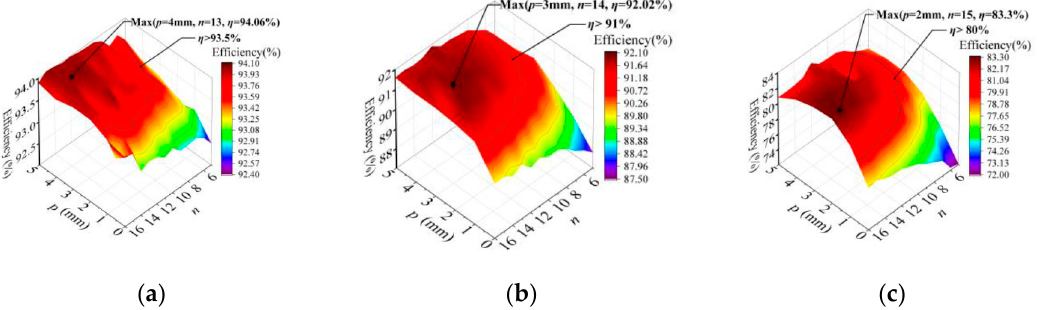
Figure 11. PTE of UAV coil with different values of n and p , at distances of ( a ) 5 cm, ( b ) 10 cm, and ( c ) 15 cm.